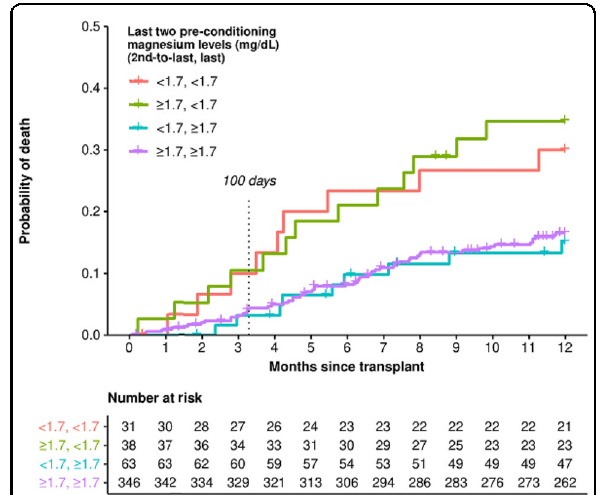
Fig. 5 Overall survival strati fi ed by magnesium levels. Overall survival of patients with diffuse large B-cell lymphoma undergoing autologous stem cell transplant by the two most recent premyeloablative serum magnesium levels.